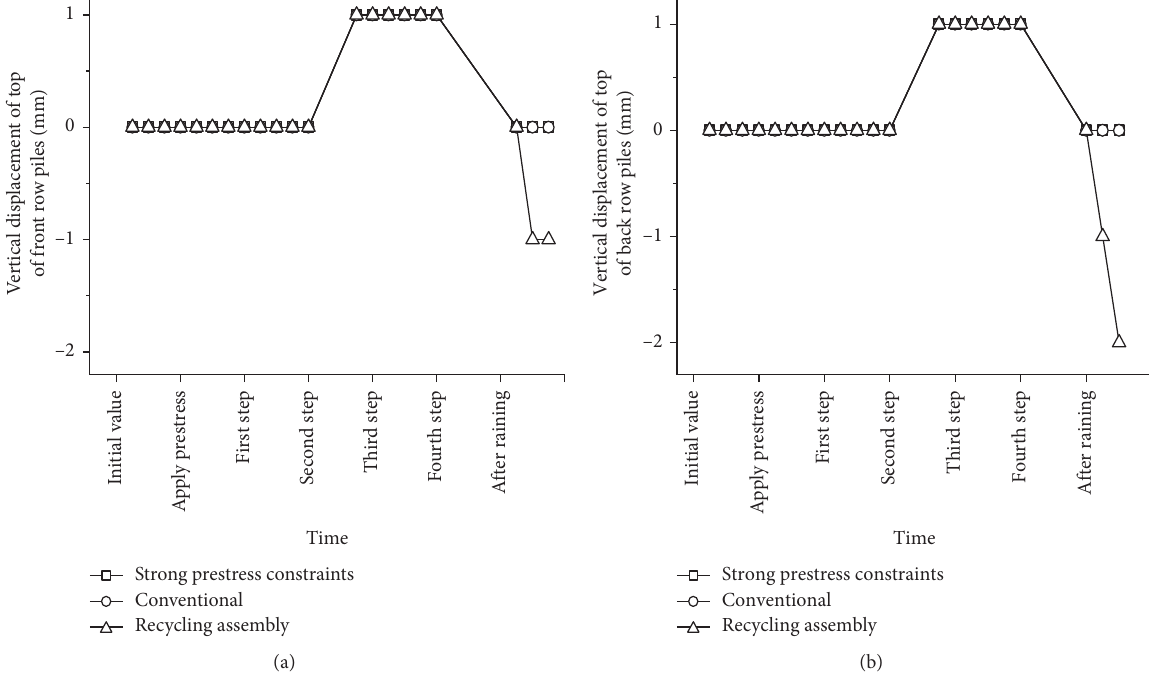
Figure 14: Comparison of vertical displacement time history of pile top. (a) Front row pile. (b) Rear row pile.